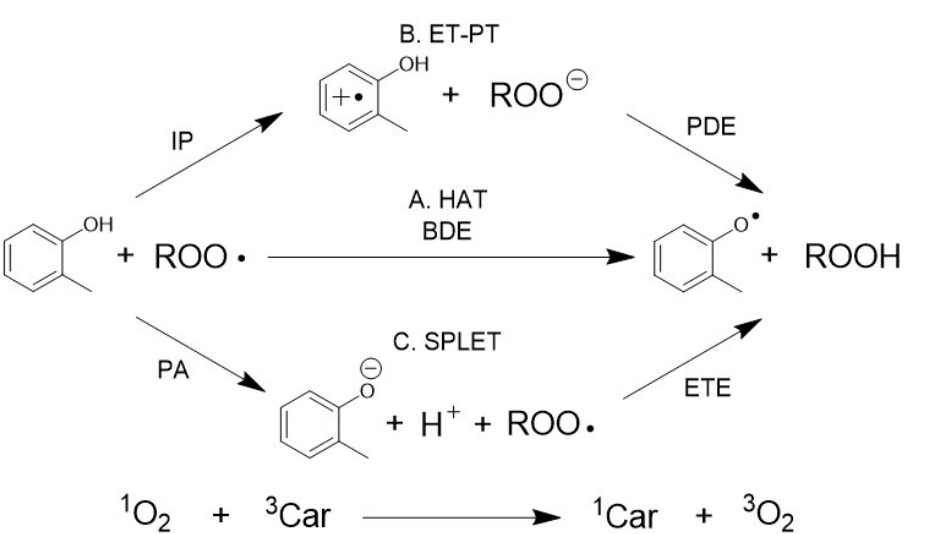
Figure 1. Well-known mechanisms of scavenging oxygen radicals and singlet oxygen. Pathway A shows the hydrogen atom transfer (HAT) mechanism, which is dependent on BDE. Pathway B shows the electron transfer–proton transfer (ET–PT) mechanism, which is dependent on IP and PDE. Pathway C shows the sequential proton loss electron transfer (SPLET) mechanism, which is dependent on PA and ETE. Singlet oxygen was quenched by physical quenching or charge transfer. We used five different assays for antioxidant capacity data: oxygen radical absorbance capacity (ORAC) [3], singlet oxygen absorption capacity (SOAC) [4], 3-(4,5-dimethylthiazole-2- yl)-2,5-diphenyltetrazolium bromide assay (MTT) [20], 2,2’-azinobis(3-ethylbenzothiazoline-6-